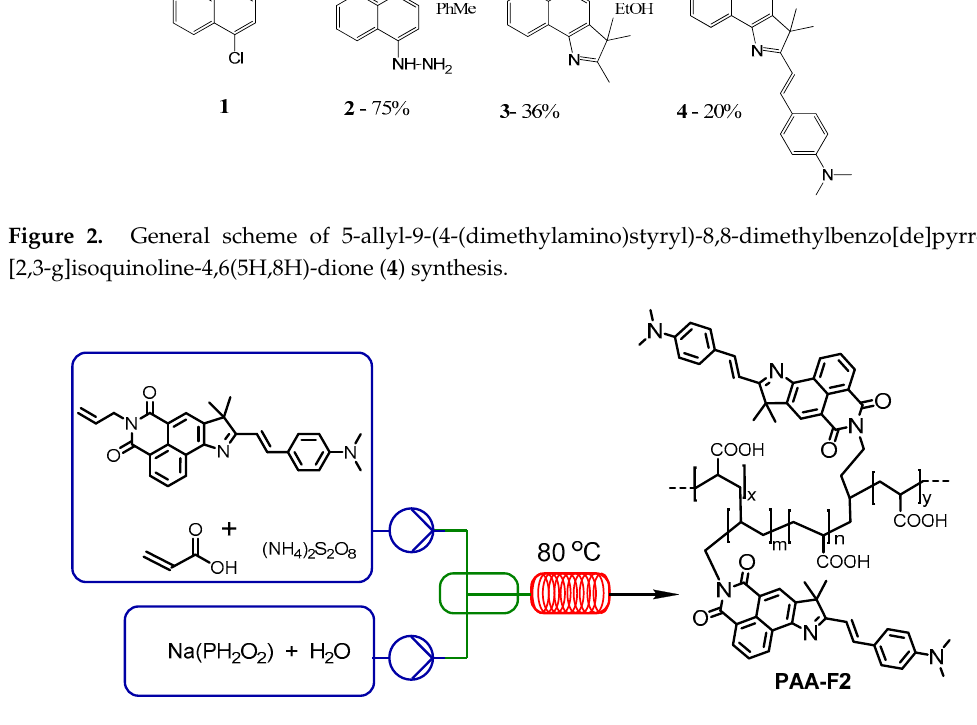
Figure 3. Scheme of the microflow 1,8-naphthalimide-tagged polyacrylate (PAA-F2) synthesis.